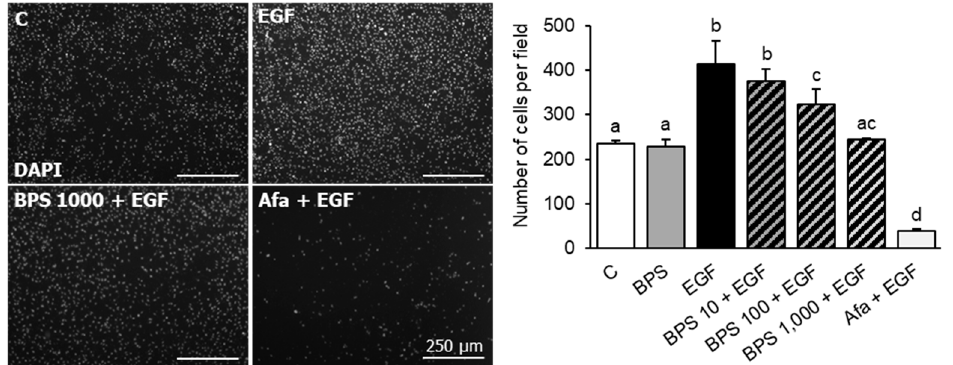
Figure 4. Effect of BPS on HTR-8/SVneo cell invasion using Matrigel pre-coated Transwell cell culture inserts. Representative images ( left ) of HTR-8/SVneo invasive cells, and quantification (mean ± SEM) ( right ) following exposure to 0.1% DMSO (control; C), BPS (1000 ng/mL), EGF (30 ng/mL), BPS (10, 100, or 1000 ng/mL) + EGF, or afatinib (Afa, 100 ng/mL) + EGF treatments. Cell invasion (mean ± SEM) was expressed as number of cells counted per field. A generalized linear model was used to compare treatments. Different letters denote statistical differences among treatment groups at p < 0.05 ( n = 4 technical